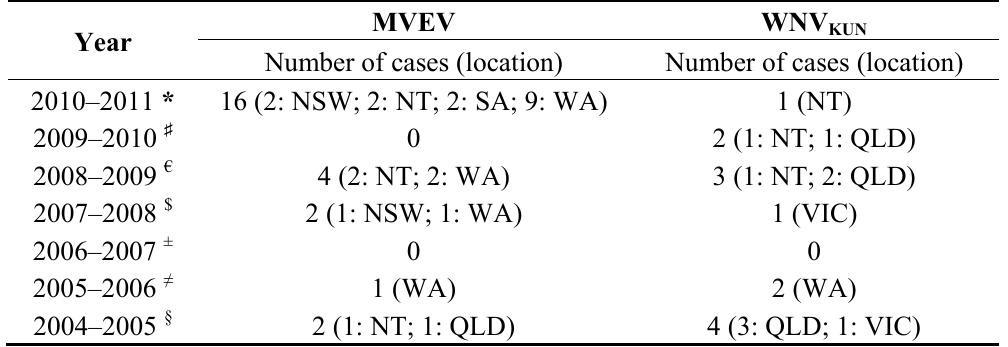
in Australia, KUN